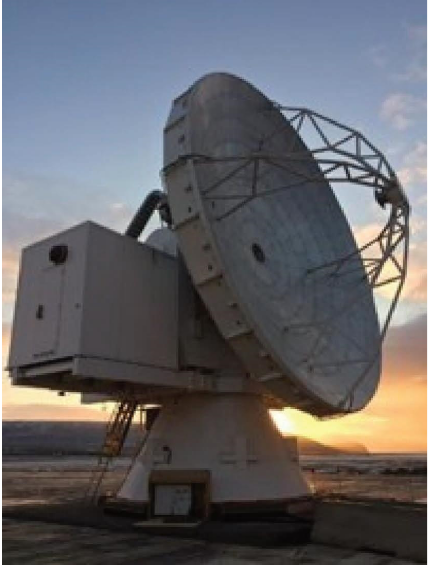
Figure 9: Greenland telescope (https://lweb.cfa.harvard.edu/ greenland12m/pictures/).